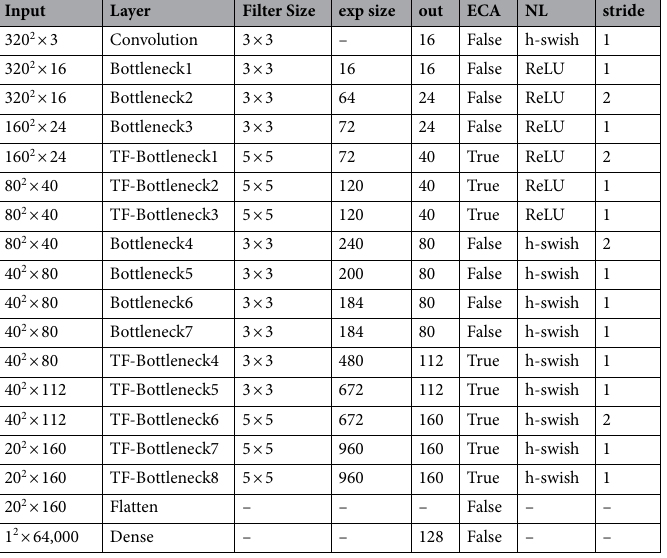
Table 3. Structure of the backbone feature extraction